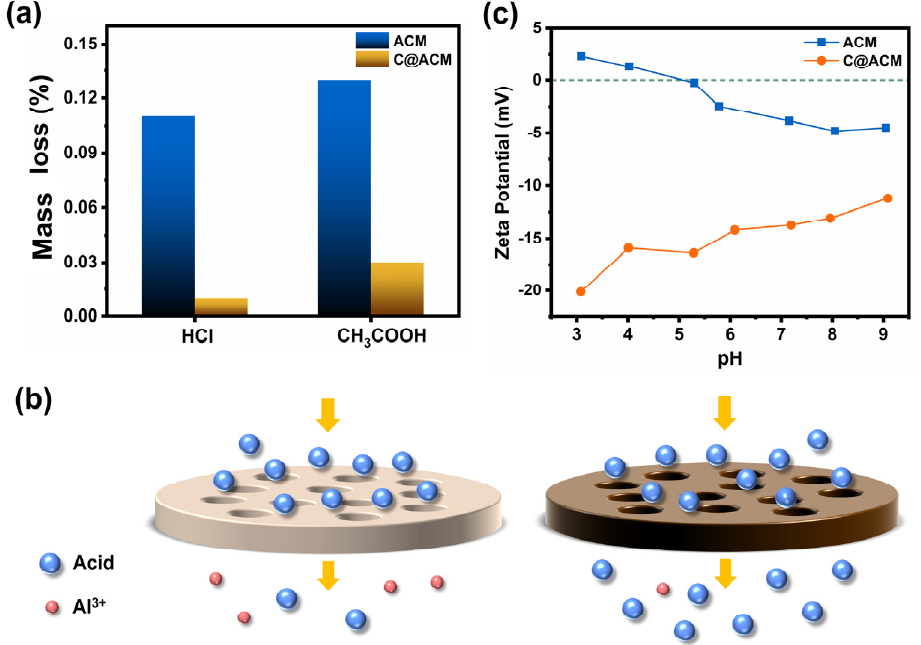
Figure 5. Acid resistance test: ( a ) mass loss of ACM and C@ACM after 24-h immersion in HCl and CH 3 COOH solution (pH = 3.50) under 80 °C; ( b ) Schematic diagram of the acid permeation process; ( c ) ζ potential of the membrane surface. Table 3. The calculated Milluiken charge of the O atom from molecular A and